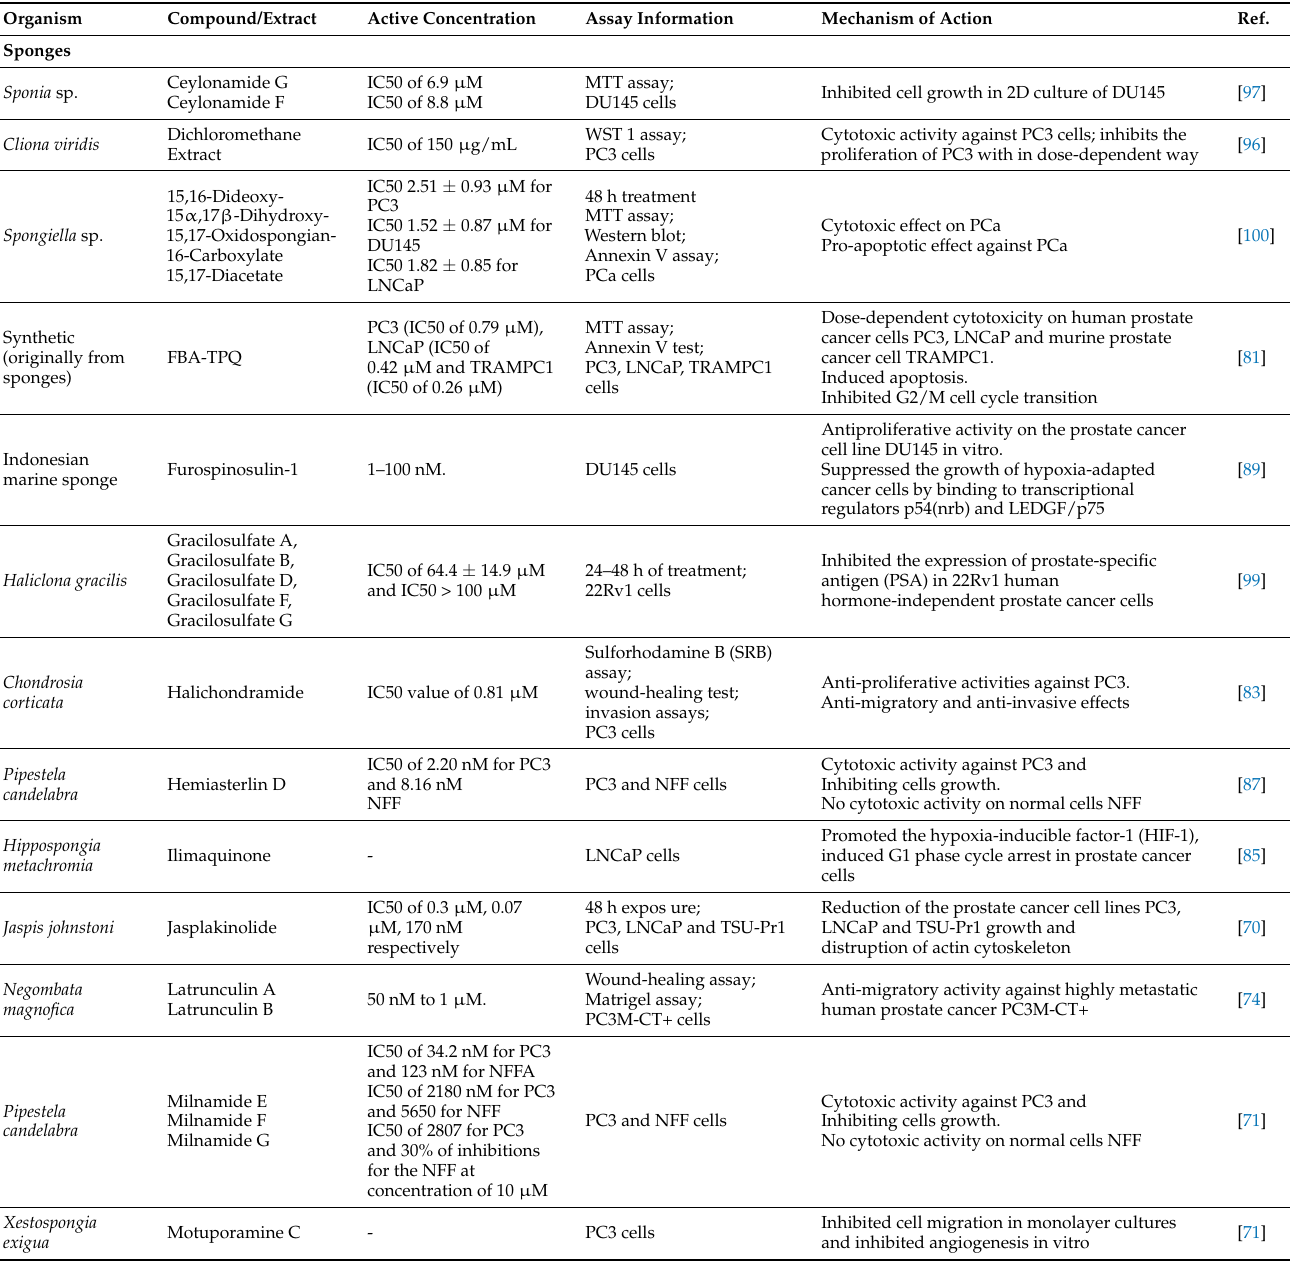
Table 3. Marine compounds/extracts from marine macroorganisms with activities against prostate cancer. The table reports in vitro and in vivo (in bold) available studies. Abbreviations: MTT for 3-(4,5-dimethylthiazol-2-yl)-2,5-diphenyltetrazolium bromide, WST-1 for water-soluble tetra- zolium salt, GI50 for 50% cell growth inhibition, IC50 for half maximal inhibitory concentration, PCa, PC3, PC3MM2, PC3M-CT+, TSU-Pr1 LNCaP, 22Rv1 and DU-145 for different prostate cancer cells. TRAMPC1 for murine prostate cancer cell. FBA-TPQ for 7-(4-fluorobenzylamino)-1,3,4,8- tetrahydropyrrolo[4,3,2-de]quinolin-8(1H)-one. TFD 100 for Thomsen-Friedenreich disaccharide (TFD)—containing glycopeptide of molecular mass 100 kDa. SPH for salmon protein